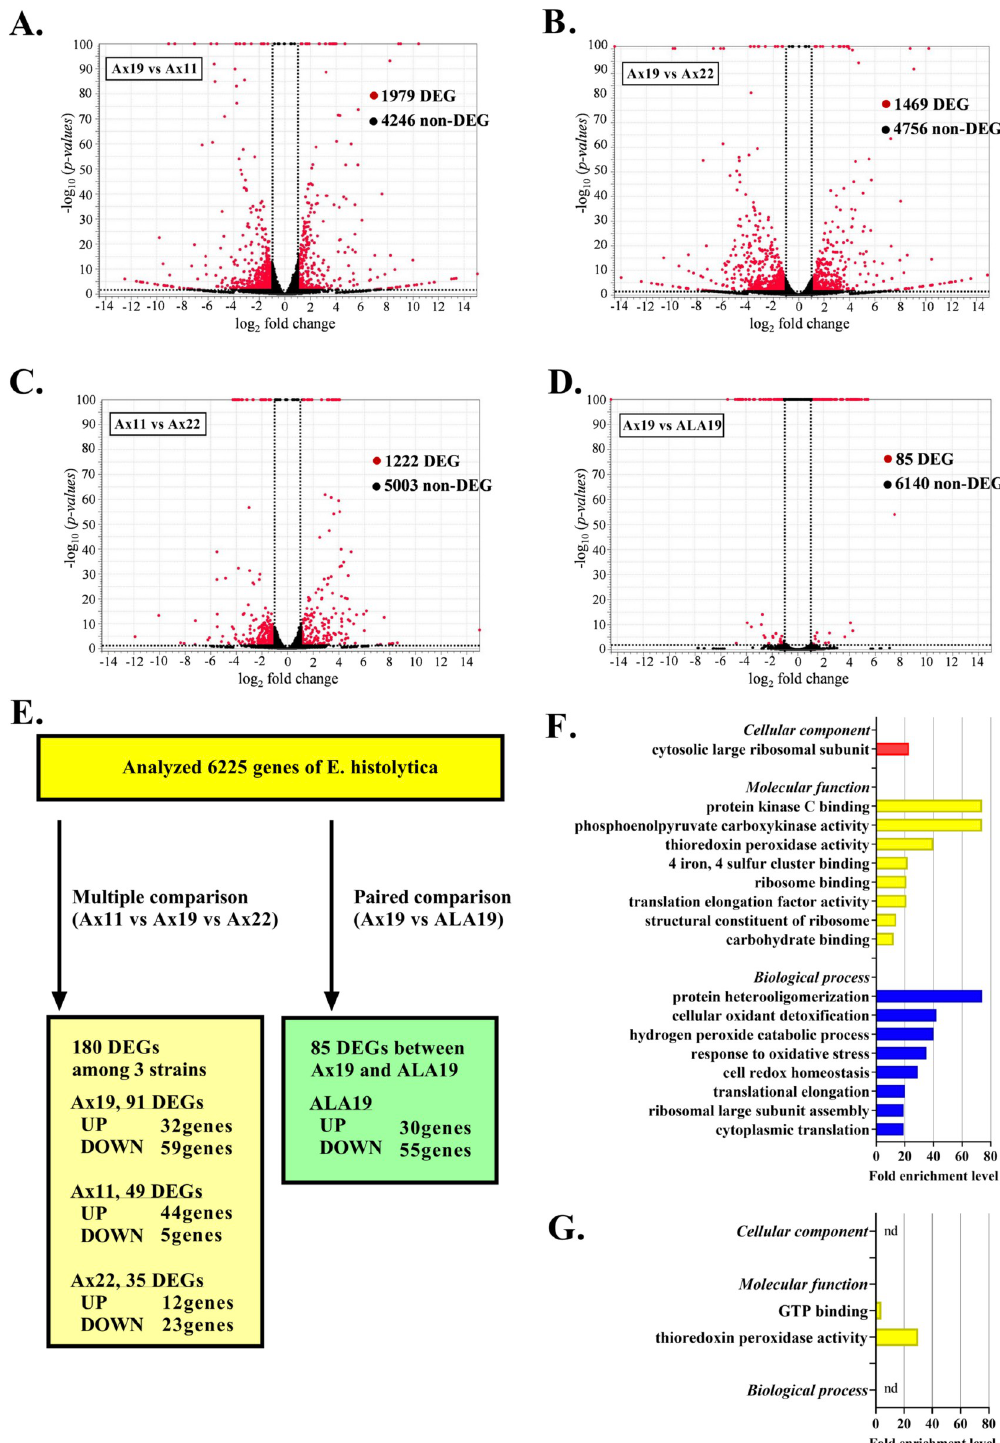
Fig 3. Systematic comparison and assessment of differentially expressed genes (DEGs) between the highly virulent strain (Ax19) and the strains of low virulence (Ax11 and Ax22). (A–D) Volcano plot showing each DEG among the E . histolytica clinical strains. The vertical axis (y-axis) corresponds to the level of significance of each gene value at log 10 (p-value), and the horizontal axis (x-axis) displays the log 2-fold change value. The red dots represent the DEGs; the black dots represent the non-DEGs. Dotted lines indicate cutoffs; fold changes greater than 2 or less than 0.5; p-value < 0.05. The greatest number